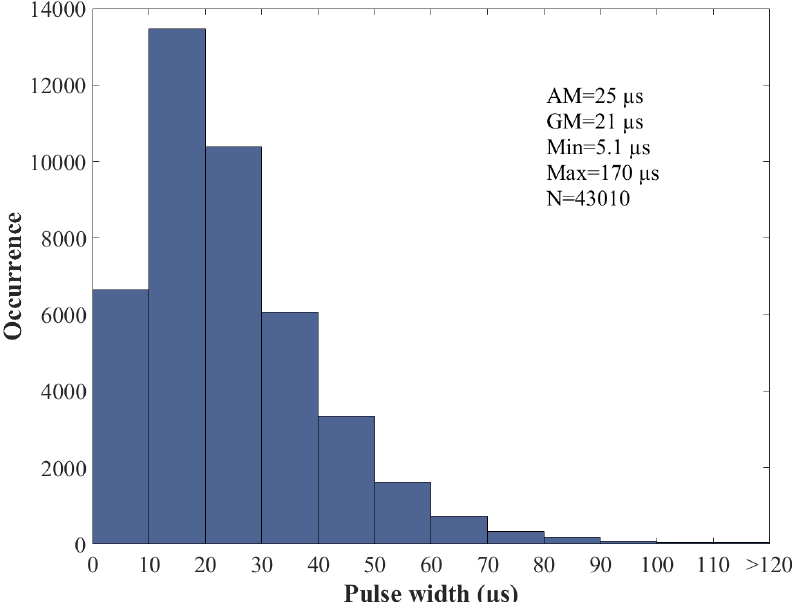
Figure 8. Histogram of bipolar pulse width in the 3077 flashes.